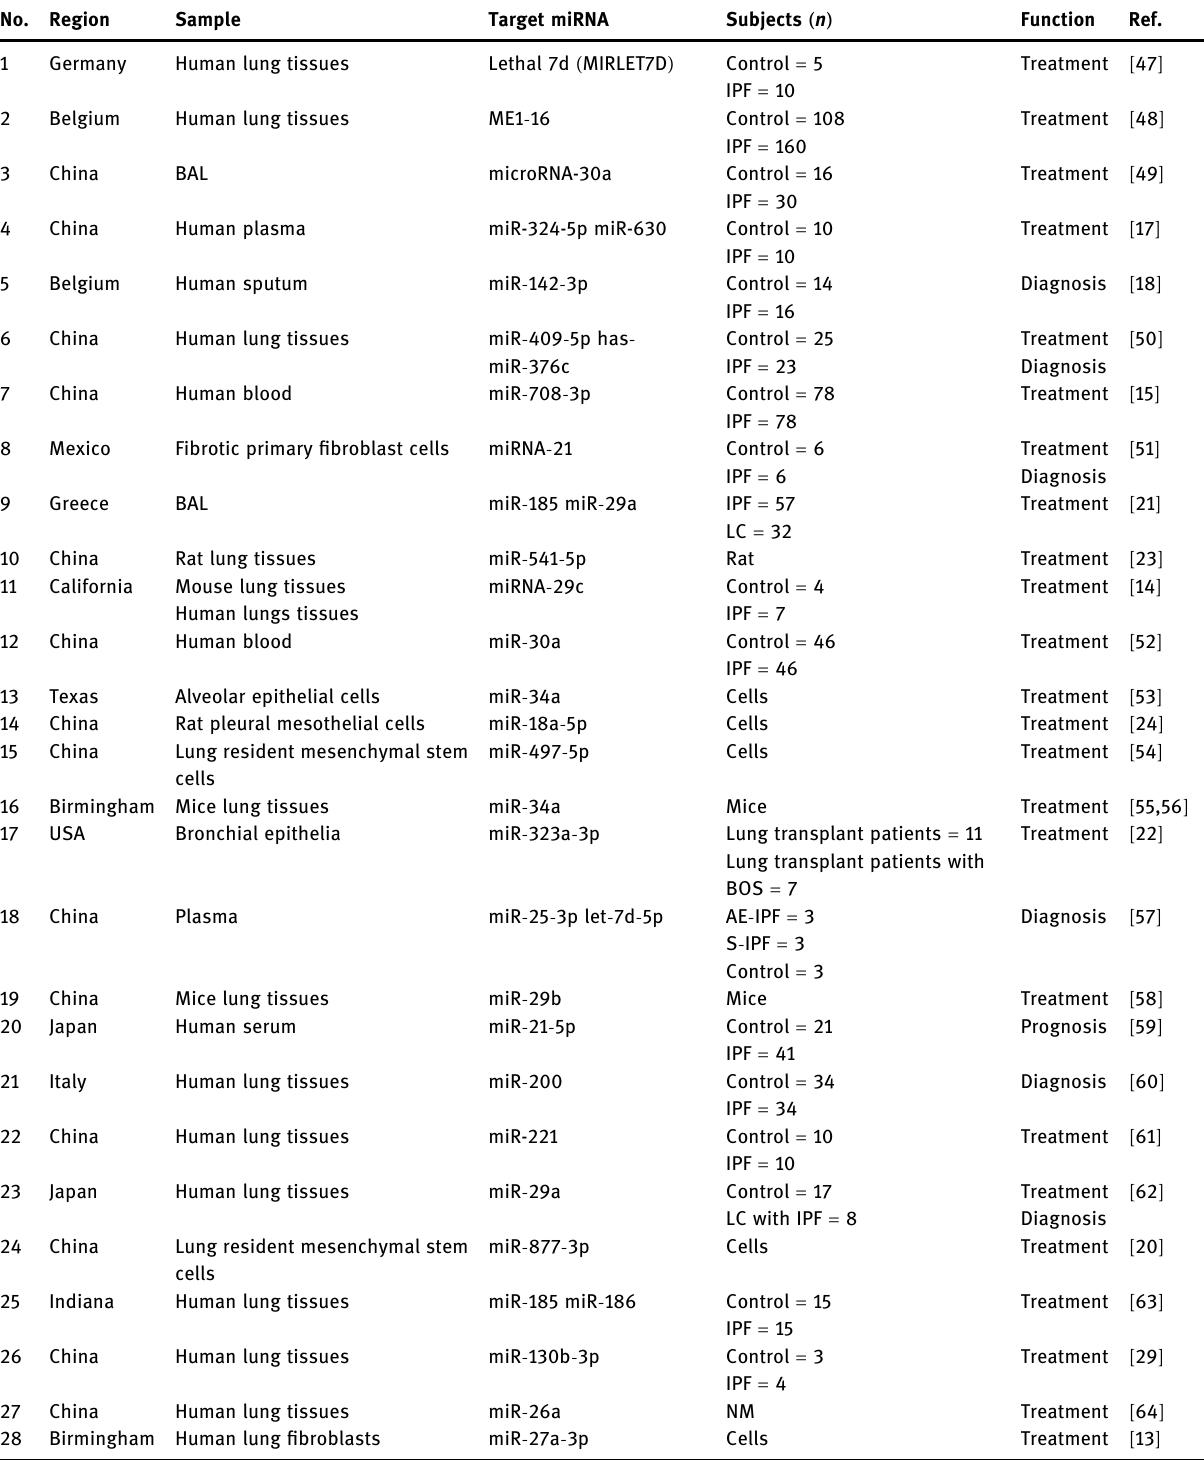
Table 1: Di ff erential expression of miRNA in IPF No.